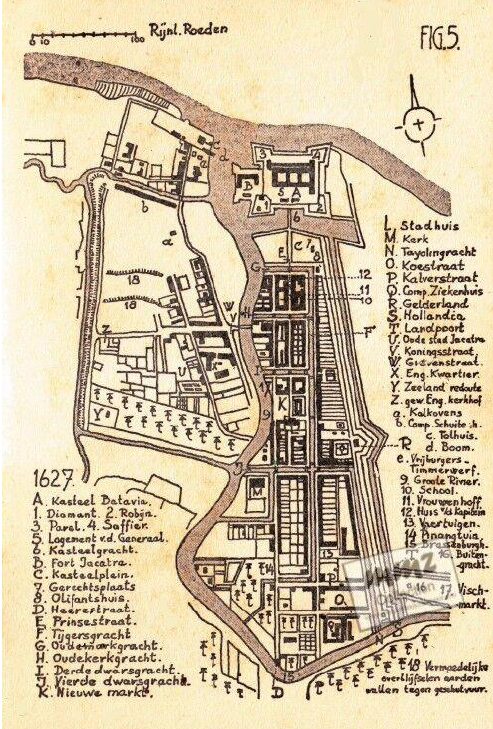
Figure 7. 1627 map emphasizes a well-defined layout of settlements as well as a new canal. Het Voormalige